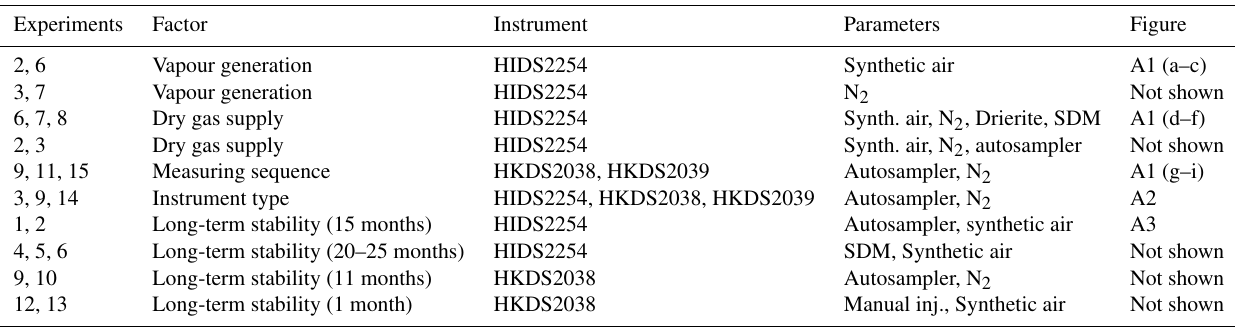
Table 3. Summary of the experiment design ordered by the aims and including the dependency on the vapour-generating method, the dependency on the tested instrument, the long-term stability of the dependency behaviour, the influence from the dry gas supply, and the influence of the measuring